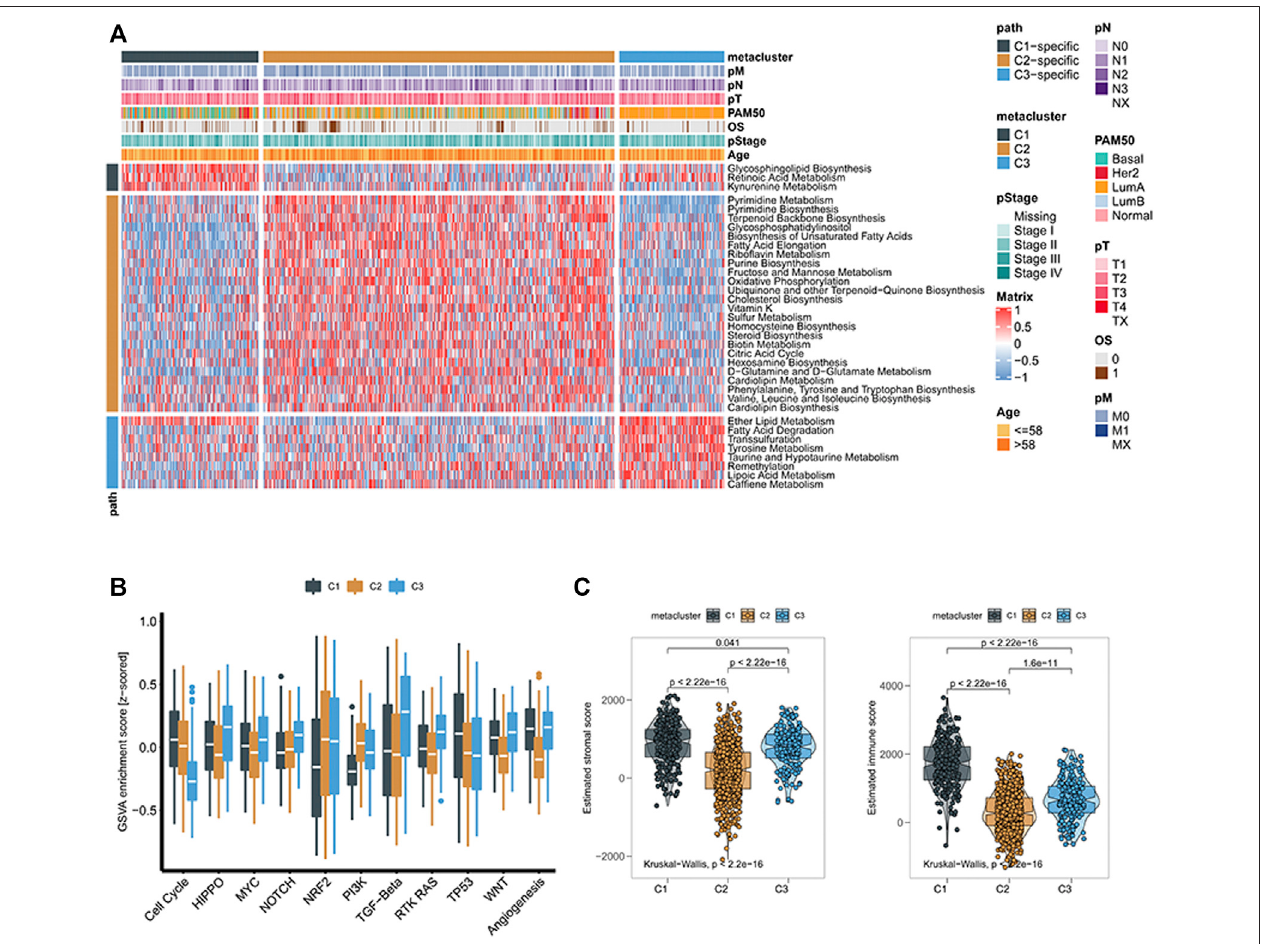
FIGURE2|(A) Heatmapsofbreastcancergenesignaturesassociatedwithmetabolism; (B) Boxplotsofcharacteristicscoresassociatedwithcancerprogression for different subclasses of breast cancer; (C) Box plots of stroma and immune scores of tumor microenvironment in different subclasses of breast cancer.